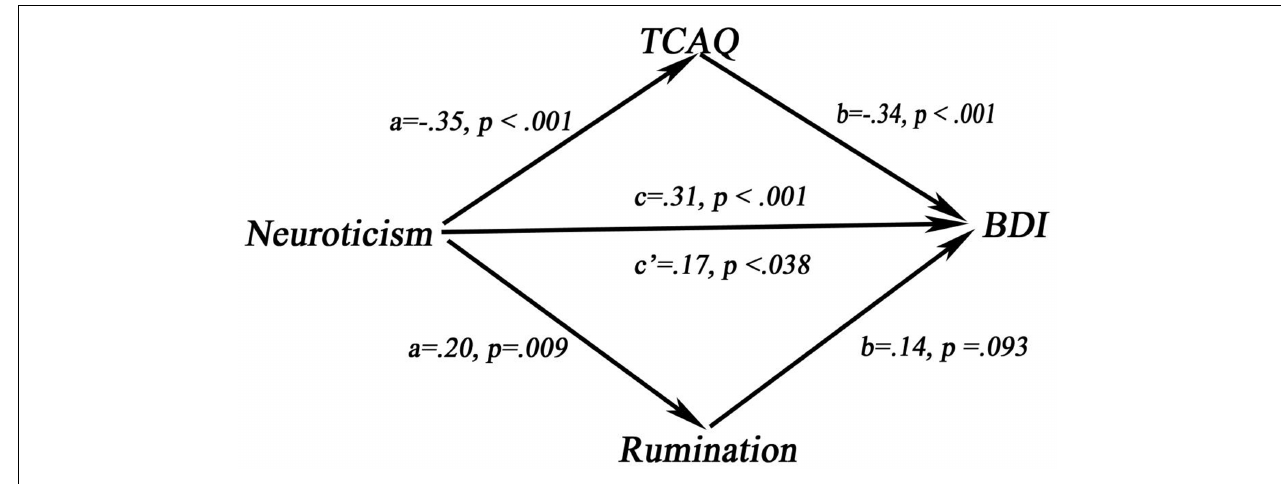
FIGURE 2 | The replication model of mediating effect.